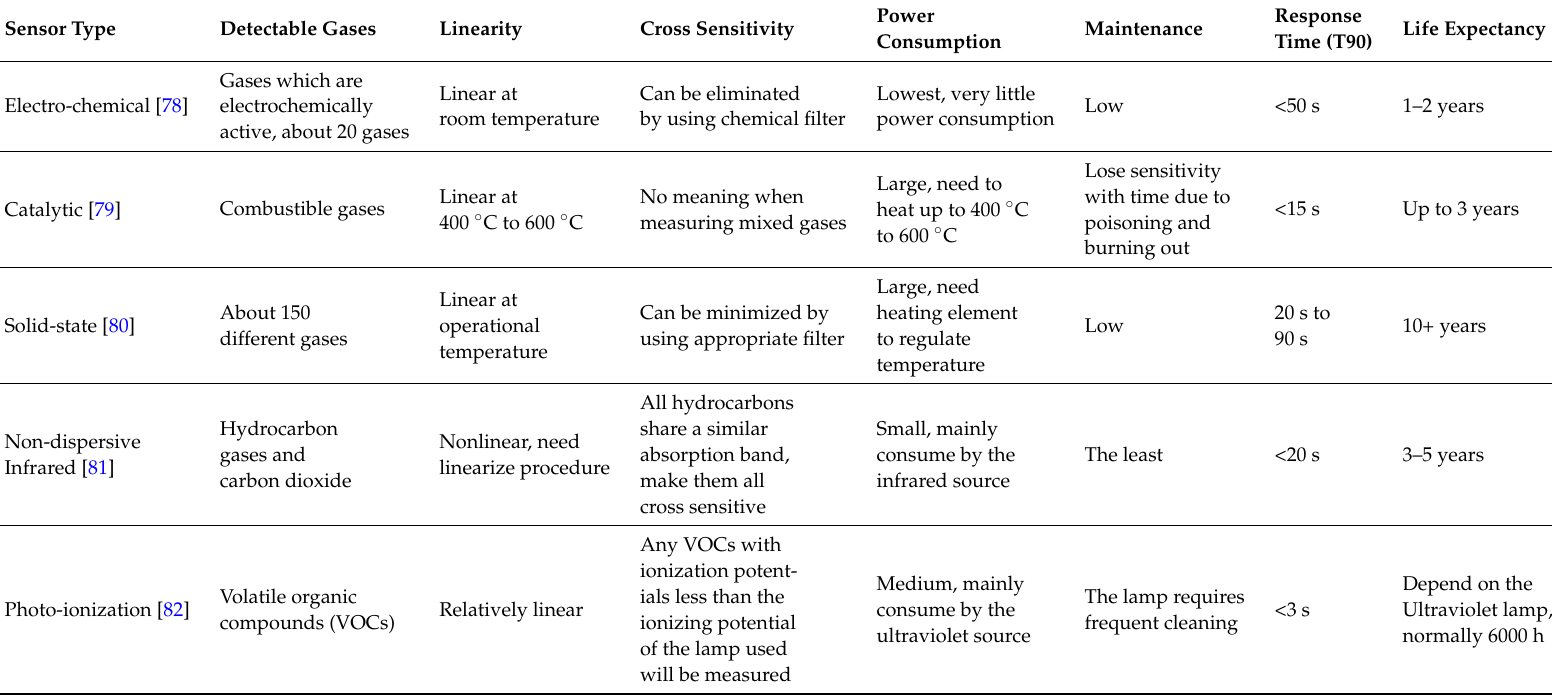
Table 7. Comparison of the five types of gas